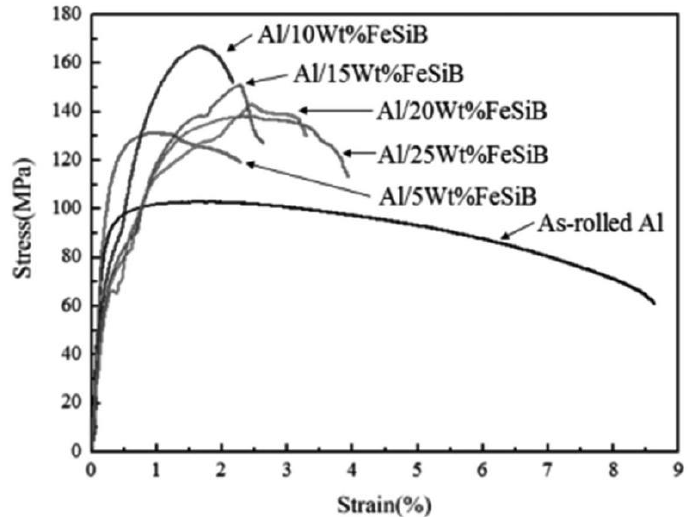
Figure 2. Tensile property curves of the roll bonding composite sheets with MG content of 5%, 10%, 15%, 20%, and 25% at initial temperature 450 °C and deformation 80%.